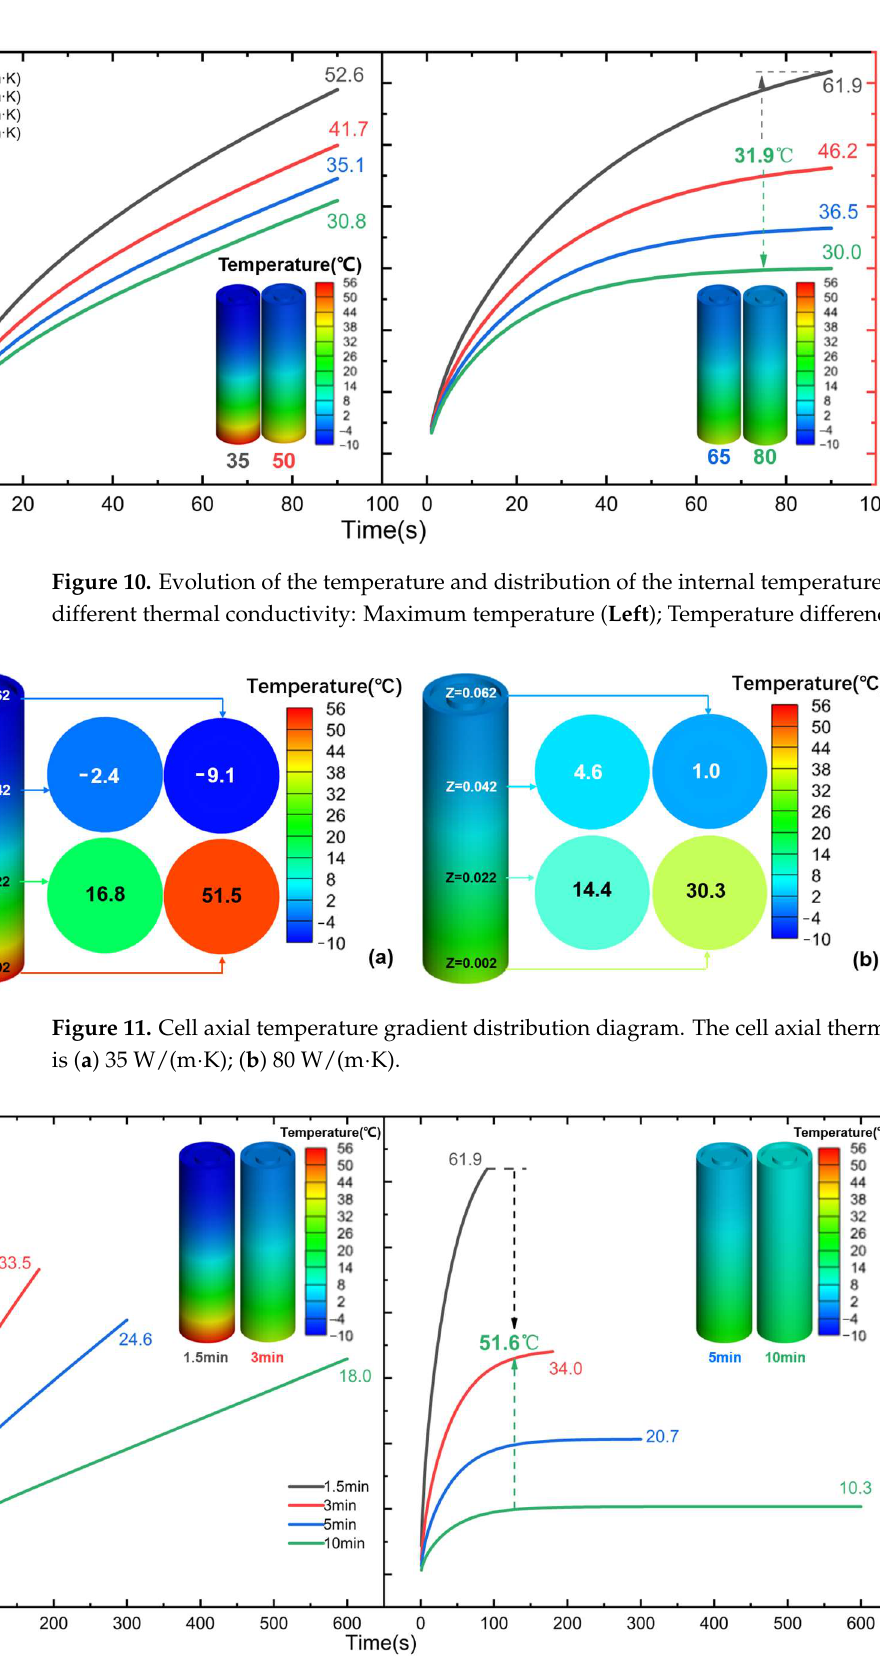
Figure 13. Cell axial temperature gradient distribution after heating for 10 min. In addition to the two methods mentioned above, reducing the heat flux at the con- tact surface by simply increasing the area heated of HF may also be a solution to the di- lemma. This part simulates the heating law of the inner four heating hours in 3 min, and the corresponding heating power is reduced from 60 W to 7.5 W while holding the heating power consumption and other parameters constant. This is illustrated in Figure 14. Simi- larly, the temperature trend exhibits the same regulation as the axial heating within the initial heating period, i.e., the temperature difference rises to the maximum temperature difference corresponding to the radial heat diffusion capacity and then remains basically the same. Undoubtedly, the longer the heating time (the lower the heating power), the smaller the temperature difference and the maximum temperature as illustrated in Figure 15. For the same 90 s (15 W) heating condition, the maximum temperature difference in- side the battery can be reduced by 91.8% with the side heating method, which is basically complying with the design concept of BTMS and fast cold start.